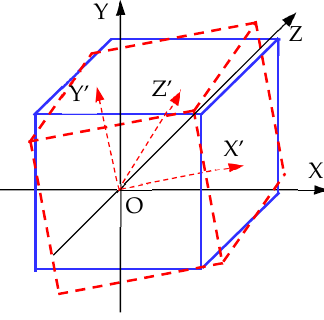
Figure 21. Coordinate correction of the 3D LiDAR.